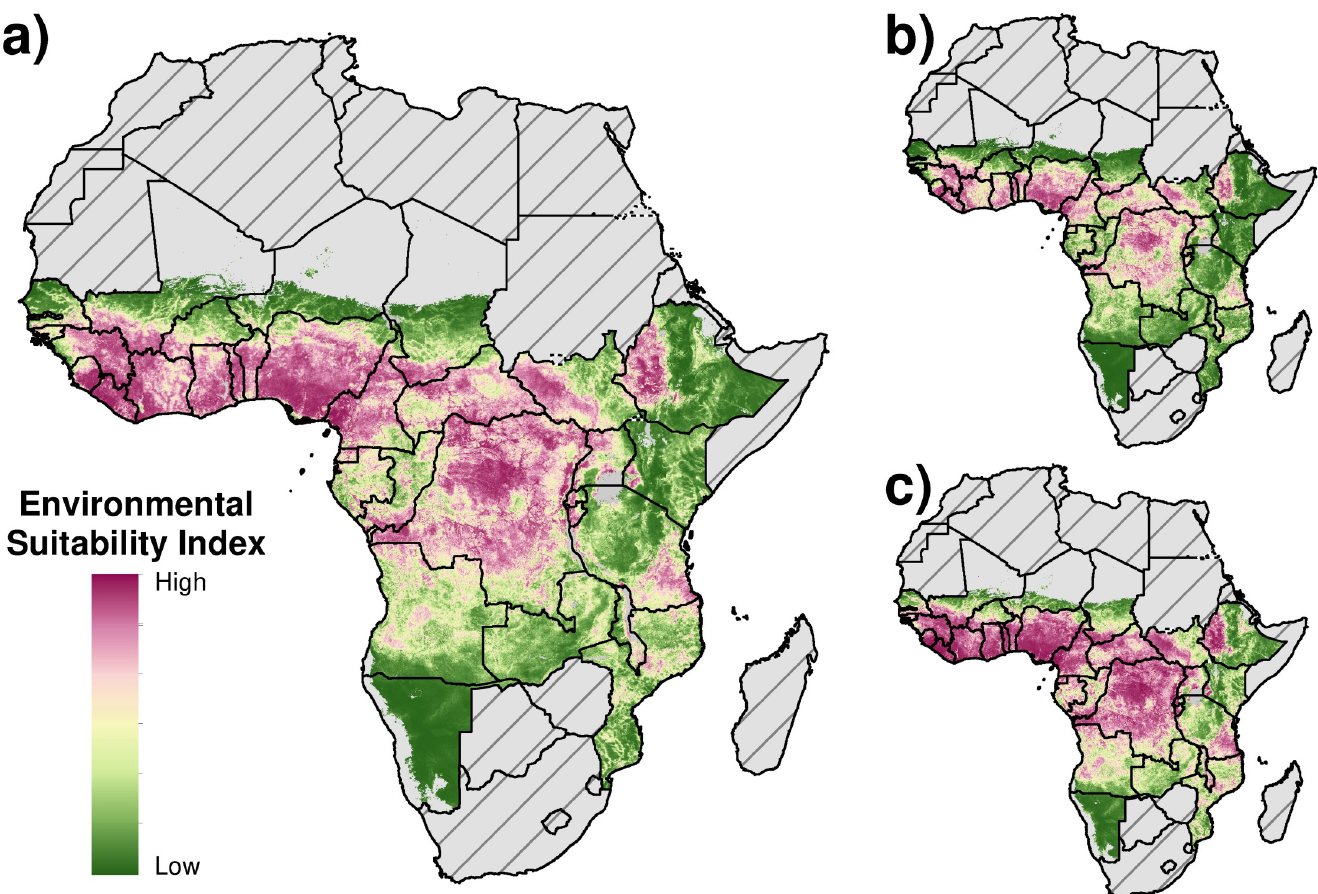
Fig 2. Environmental suitability predictions: Visualisation of (a) mean, (b) lower 95% uncertainty interval, and (c) upper 95% uncertainty interval. Environmental suitability index predicted by the model is bounded from 0% (low) to 100% (high). Countries in grey were excluded from the analysis. Countries in grey with hatch marks were excluded from the analysis based on a review of national endemicity status. Areas in grey only represent locations masked due to sparse population. Maps were produced using ArcGIS Desktop 10.6 and shapefiles to visualize administrative units are available at https://espen.afro.who.int/tools-resources/cartography-